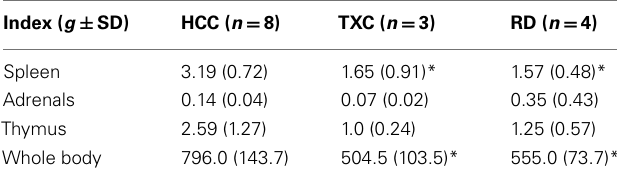
Table 1 | Means ( g ± SD) for Seyle’s stress